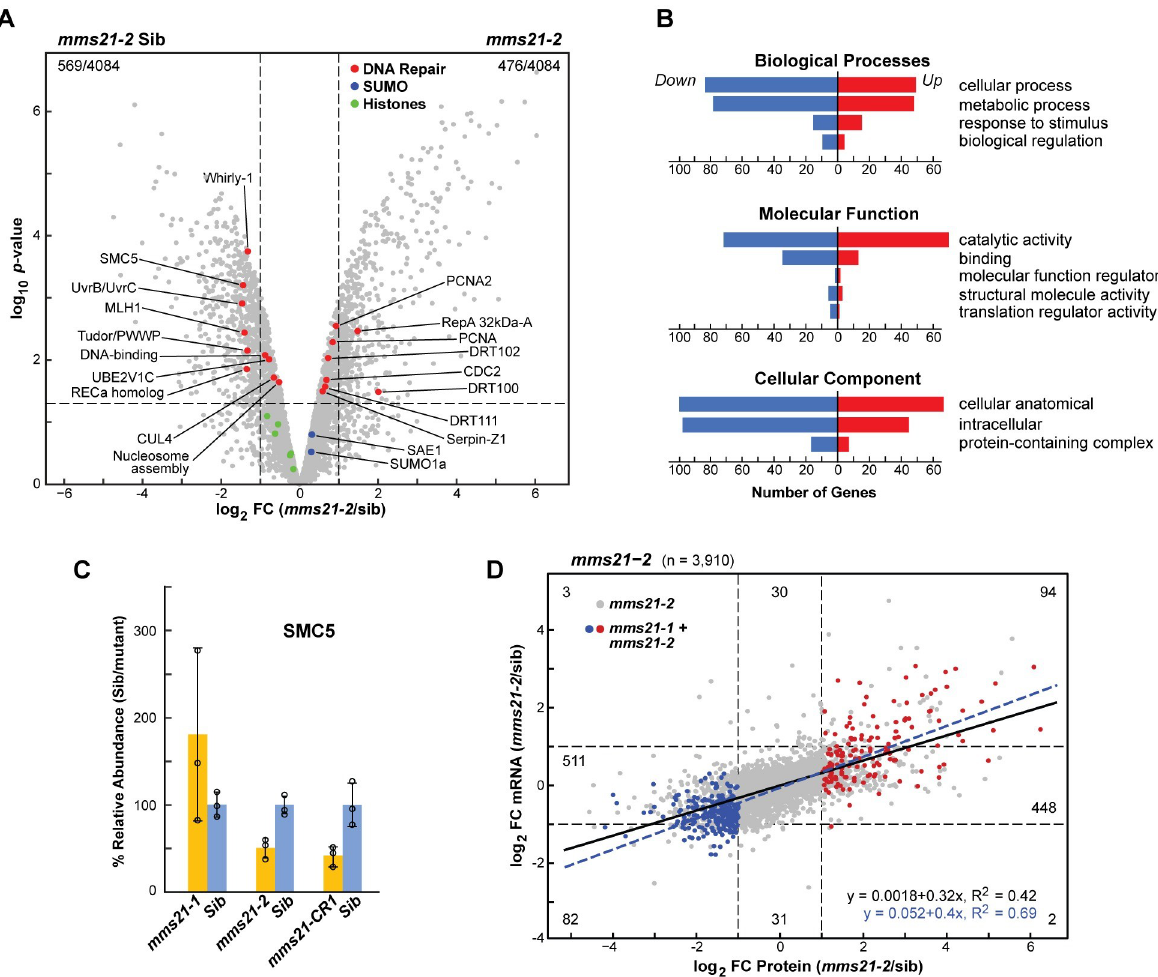
Fig 7. mms21 Mutants have Altered Proteome Profiles and Reduced SMC5 Levels. (A) Altered proteome profile for the mms21-2 mutant. The volcano plot depicts protein abundance changes for 4,084 proteins detected from mms21-2 leaves as compared to those of its normal sibling. Each dot represents one protein that had detectable expression in both samples and was plotted based on its log 2 FC in abundance (mutant/normal siblings) and its -log 10 p -value of significance based on the three biological replicates, each with two technical replicates. The horizontal and vertical dashed lines mark a FC = 2 in protein abundance and a p- value = 0.05, respectively. Histone proteins used to confirm data normalization are shown as green. SUMO pathway components and DNA repair-associated proteins are highlight in blue and red respectively. (B) GO analysis of significantly regulated proteins in the mms21 mutant versus W22 seedlings. The vertical coordinates indicate the enriched GO terms, and the horizontal coordinates show the number of genes for each GO term when comparing differentially expressed genes common between mms21-1 and mms21-2 seedlings. Negative values indicate downregulation, positive values indicate upregulation. GO enrichment was performed using all the three sub-ontologies: ‘biological process’, ‘molecular function’, and ‘cellular component’. (C) SMC5 protein abundance is reduced in strong mms21 mutant backgrounds. Relative protein abundances of SMC5 from the mms21-1 , mms21-2 and mms21-CR1 mutants and their normal siblings. Each bar represents the mean of three biological replicates( ± SD). (D) Positive correlation between transcriptome and proteome data in mms21 mutants. Scatter plot showing the relationship between changes in protein and mRNA abundances for the mms21-2 mutant versus normal sibling as determined by plotting the log 2 FC in mRNA abundance versus the log 2 FC in protein abundance. Red dots (154) and blue dots (277) highlight proteins that were more or less abundant (FC > 2), respectively, in both mms21-1 and mms21-2 leaves as compared to their normal siblings. The black and dashed blue lines show the correlations for mms21-2 and for the combined data of mms21-1 and mms21-2 (red and blue